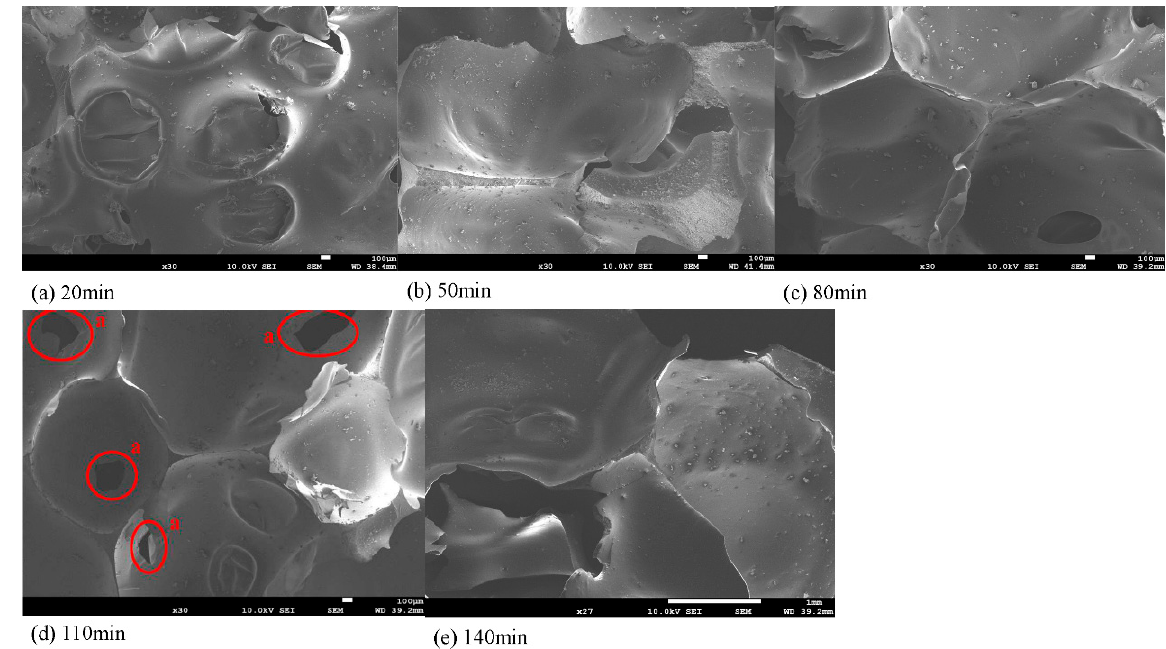
Figure 10. SEM micrographs of polyurethane foams prepared using different polyols at different liquefaction times.